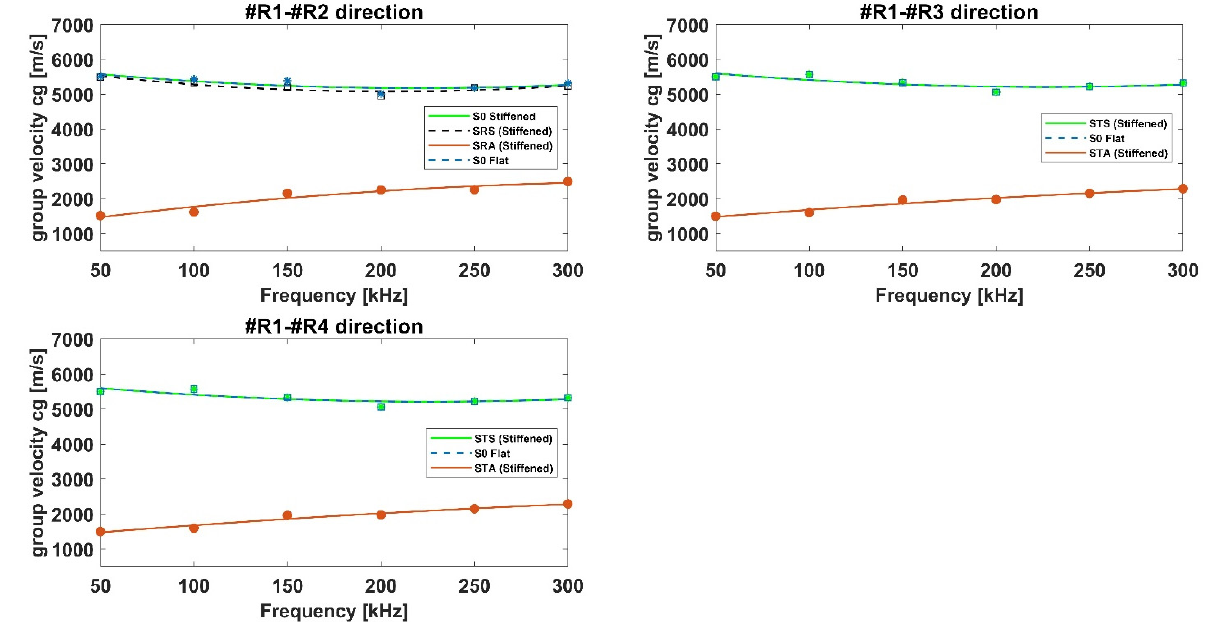
Figure 12. Comparison of the group velocities of the incident and converted/reflected S 0 modes detected in the flat and reinforced configurations – aluminum panels.